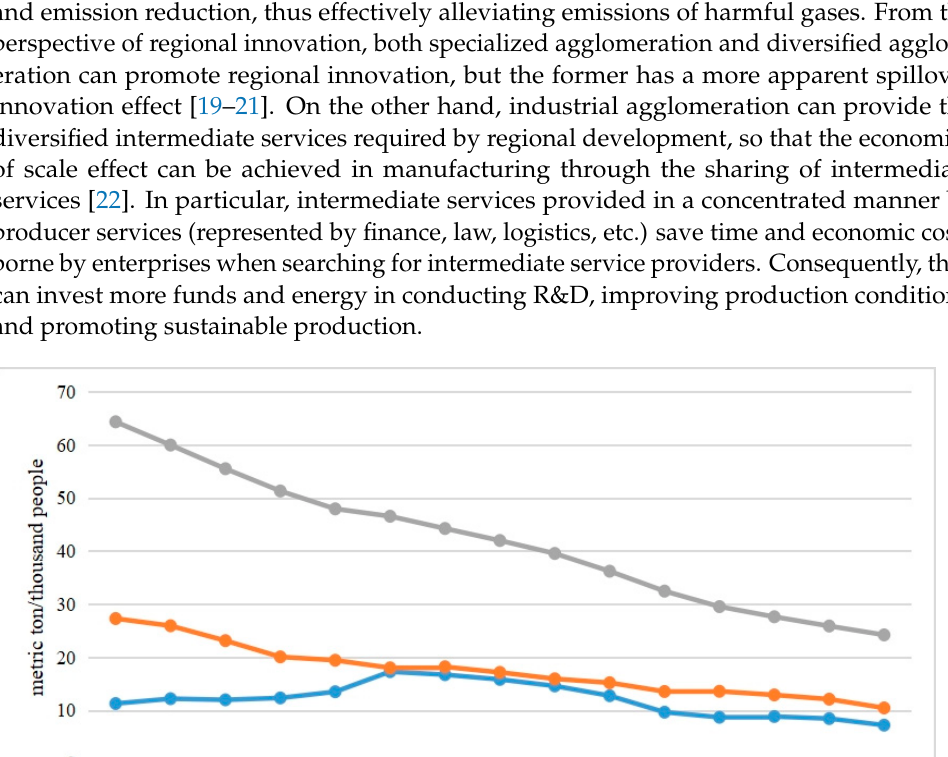
Figure 2. 2006–2020 China, the UK, and the US NO x air pollution. (NO x emission metric Figure2. 2006-2020 China, the UK, and the US NO x air pollution. (NO x emission metric ton/thousand people). ton/thousand people). Data source: ourworldindata.org. Data source: ourworldindata.org